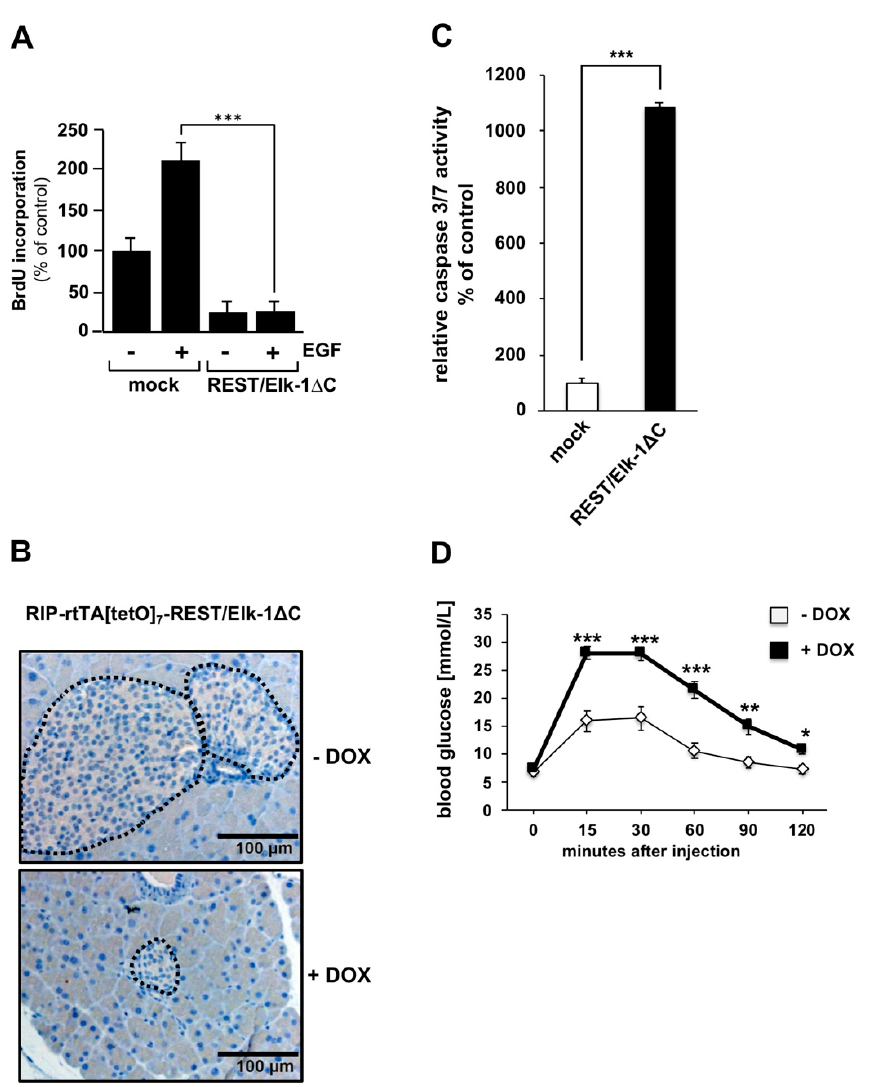
Figure 4. Biological functions of Elk-1. ( A ) Primary astrocytes were infected with a recombinant lentivirus encoding REST/Elk-1 Δ C. As a control, mock-infected cells were analyzed. Cells were stimulated with EGF (10 ng mL − 1 ) for 24 h. DNA synthesis was measured by the incorporation of BrdU into the DNA that was detected by an immunoassay (*** p < 0.001). ( B ) Attenuation of Elk-1 activity in pancreatic β -cells resulted in the generation of significantly smaller islets. Transgenic mice were analyzed that allowed the doxycycline (Dox)-dependent expression of the dominant-negative mutant of Elk-1, REST/Elk-1 Δ C, specifically in pancreatic β -cells. H&E-stained sagittal sections of pancreata derived from these mice that had received doxycycline supplementation in the drinking water showed significantly smaller islets in comparison to control mice. ( C ) Inhibition of Elk-1 activated caspase-3/7. INS-1 832/13 insulinoma cells were infected with a recombinant lentivirus encoding REST/Elk-1 ∆ C as indicated. The cells were incubated in DME medium containing 0.5% serum and 2 mM glucose for 74 h. The caspase-3/7 activity was determined with the “CaspaseGlo-Substrate”. ( D ) Impaired glucose tolerance in transgenic mice expressing REST/Elk-1 ∆ C in pancreatic β -cells. A glucose tolerance test was performed with 10 week-old double-transgenic RIP-rtTA/[tetO] 7 REST/Elk-1 ∆ C mice that were maintained either in the presence or absence of doxycycline (DOX) in the drinking water. The animals were injected with glucose (2 g/kg body weight), and blood glucose levels were measured at different time points. Blood glucose concentrations were determined (data shown are mean +/ − SEM or +/ − SD; * p < 0.05; ** p < 0.01; *** p < 0.001; n = 3). Reproduced with modifications from Refs. [8,21], with permission from the Company of Biologists, John Wiley and Sons and